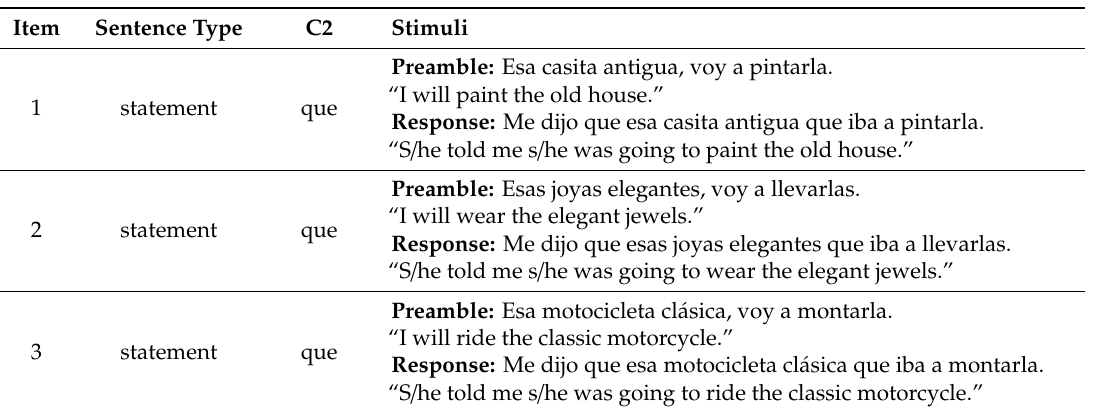
Table A1. Stimuli for Acceptability Judgment